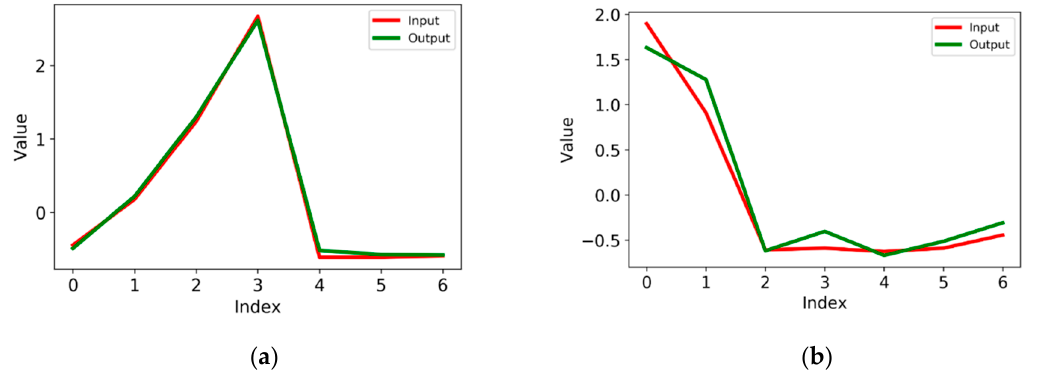
Figure 10. Test set test results. ( a ) Random set 1; ( b ) random set 2.